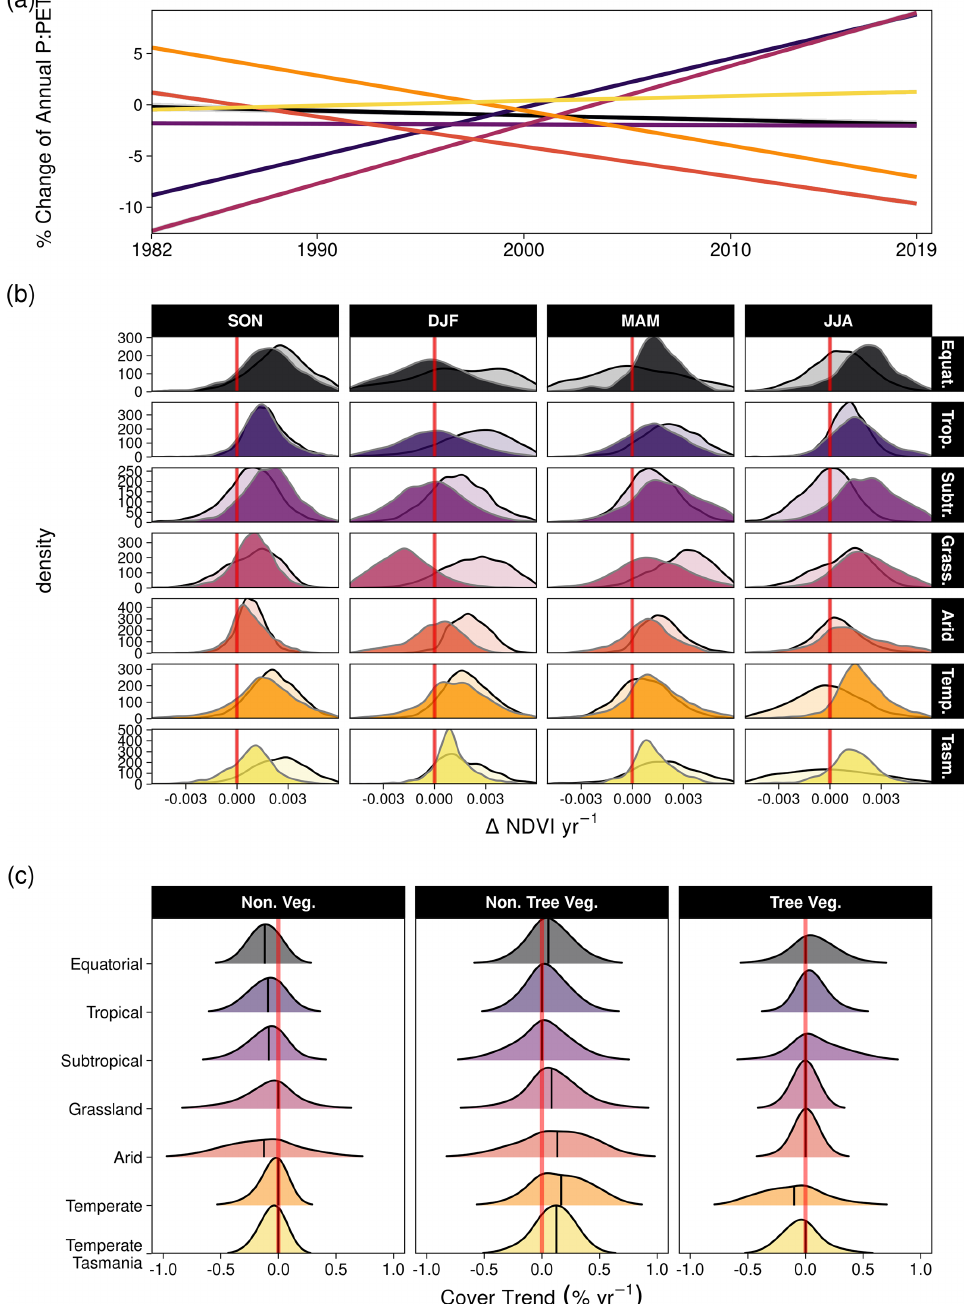
Figure 8. The relative percentage change in P :PET by climate zone and corresponding distributions of (cid:49) NDVIyr − 1 and percentage annual change in vegetation cover fraction. (a) The linear relative changes in annual P :PET trend by climate zone between 1982–2019, as estimated by robust regression (see “Methods”). The annual P :PET change (%) and corresponding standard error were as follows: Equatorial ( − 0 . 045 ± 0.01), Tropical (0.477 ± 0.005), Subtropical ( − 0 . 007 ± 0.005), Grassland (0.576 ± 0.006), Arid ( − 0 . 293 ± 0.006), Temperate ( − 0 . 342 ± 0.004), and Temperate Tasmania (0.047 ± 0.005). (b) Distribution of linear long-term NDVI trends for the six climate clusters by season using the Theil–Sen estimator. Filled distributions are trends from the MODIS sensors (2001–2019), and transparent (black outline) distributions are from the AVHRR sensors (1982–2000). (c) Distributions of the linear pixel-level trends using the Theil–Sen estimator for non-vegetated cover, non-tree vegetation cover, and tree cover between 2000–2018. The median is overlaid. Note that climate zone abbreviations are as follows: Equatorial (Equat.), Tropical (Trop.), Subtropical (Subtr.), Grassland (Grass.), Temperate (Temp.), and Temperate Tasmania